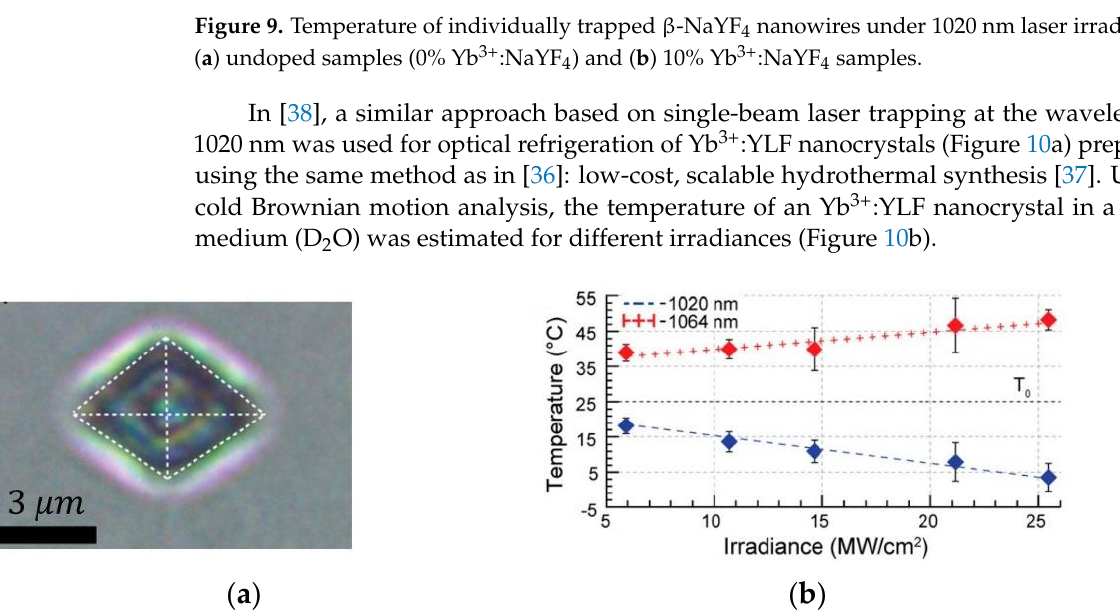
Figure 10. Laser cooling of laser-trapped Yb 3+ :YLF microcrystals. ( a ) Optical micrograph of a laser- trapped Yb 3+ :YLF crystal. ( b ) Temperature of laser-trapped particles in D 2 O as determined using the cold Brownian motion analysis [38].